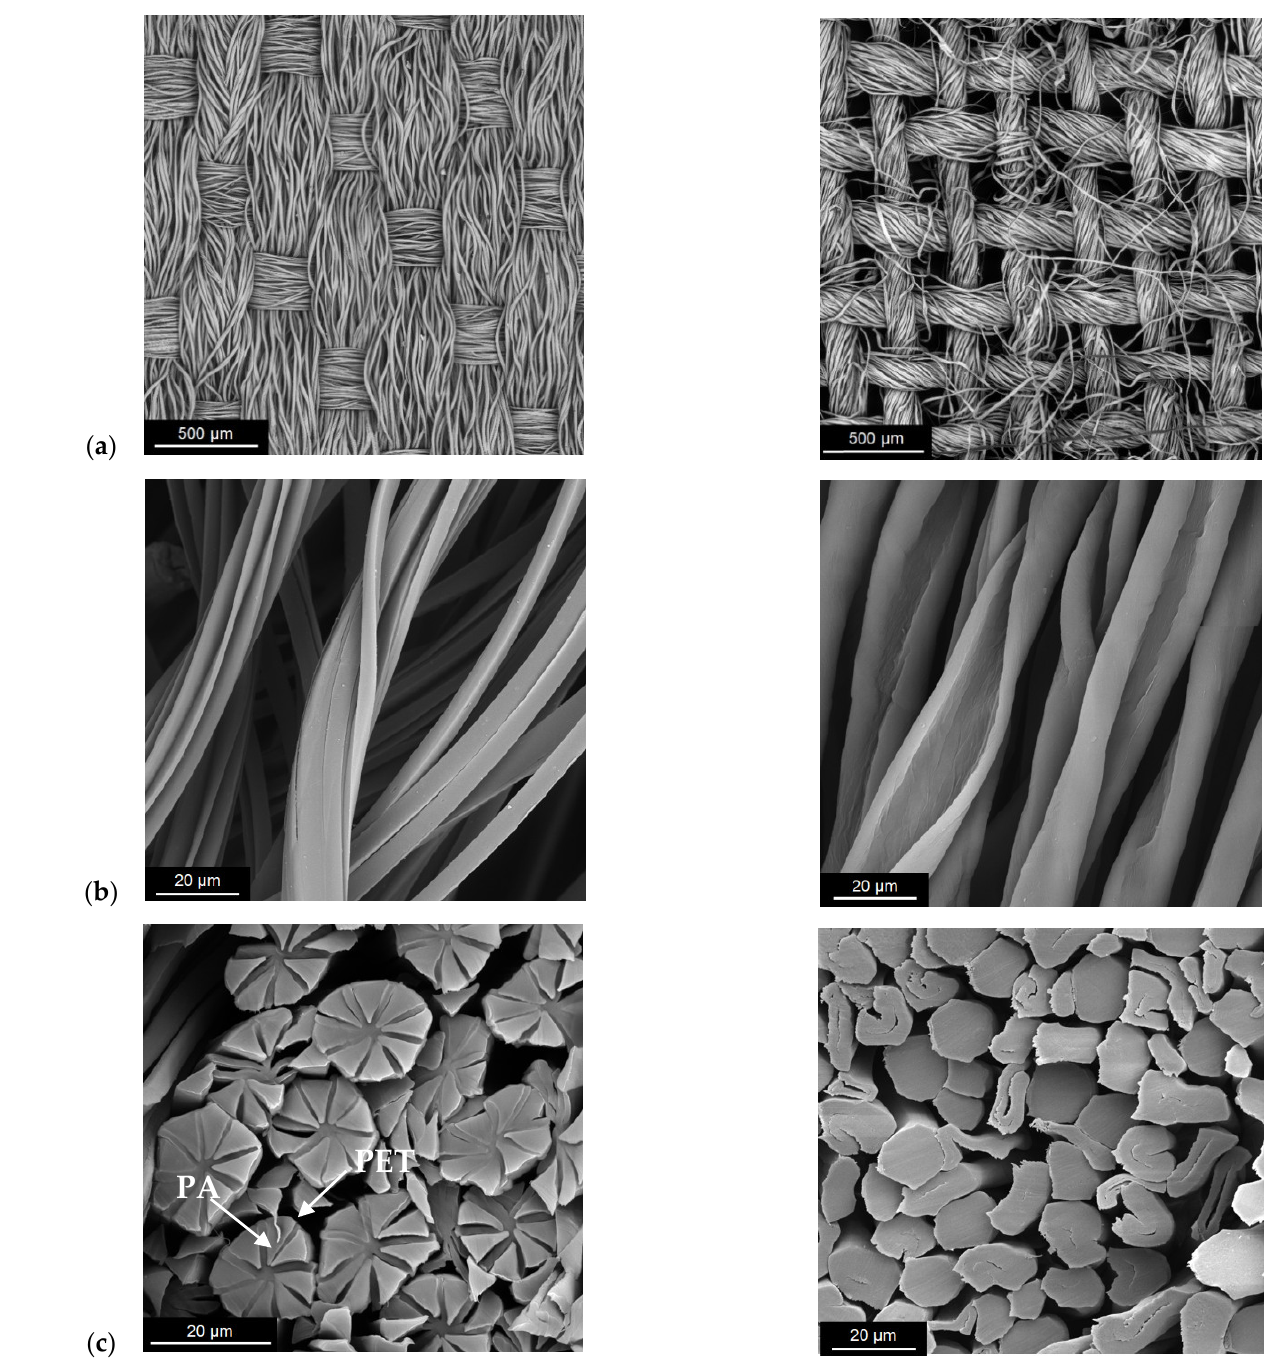
Figure 2. The SEM images of textile materials used in the study: ( a ) woven fabrics, ( b ) longitudinal and ( c ) cross section views of the fibers.